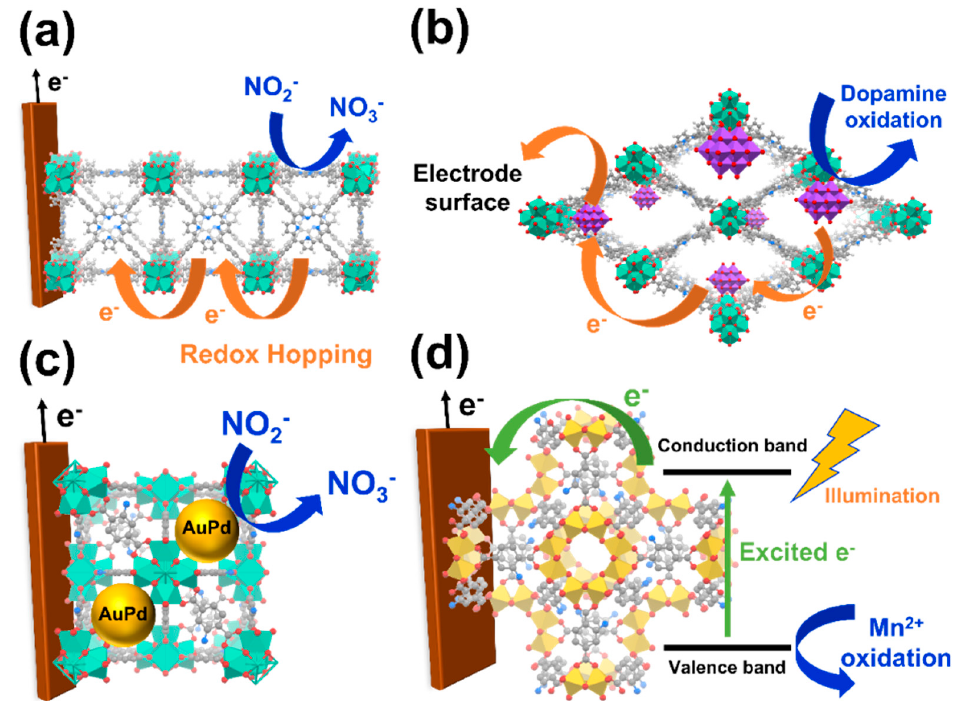
Figure 9. ( a ) The use of a redox-active porphyrinic Zr-MOF, MOF-525, to render hopping-based charge transport and electrochemically detect nitrite [166–168] . ( b ) Immobilization of V 10 O 28 clus- ters within a Zr-MOF, NU-902, to render both the charge transport and the electrocatalytic activity for dopamine detection [191] . ( c ) AuPd nanoparticles immobilized within UiO-66-NH 2 for electro- chemical nitrite detection [193] . ( d ) Photoelectrochemical detection of Mn 2+ ions by utilizing a Ti- MOF, NH 2 -MIL-125(Ti), as the catalytic thin films [196] . Elemental colors used in the MOF struc- NH 2 -MIL-125(Ti), as the catalytic thin films [196]. Elemental colors used in the MOF structures: tures: cyan—Zr; yellow—Ti; purple—V; red—O; blue—N; grey—C; white—H. cyan—Zr; yellow—Ti; purple—V; red—O; blue—N; grey—C;